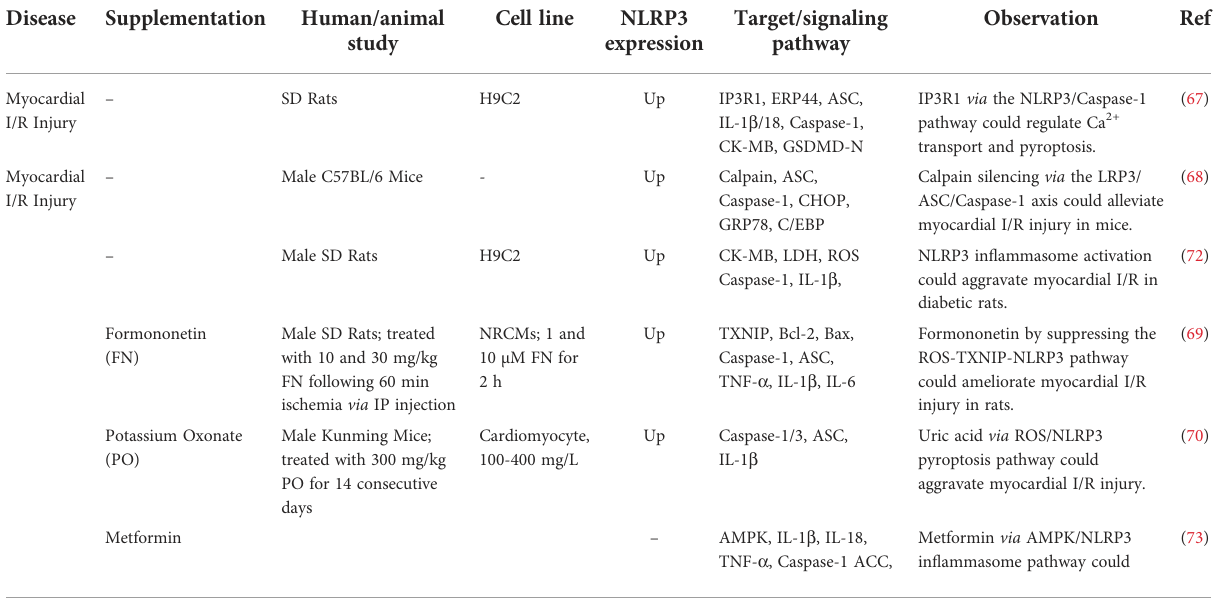
TABLE 3 Impact of NLRP3 in Myocardial I/R Injury. Disease